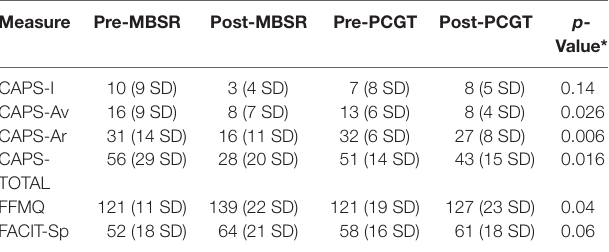
TaBle 2 | Effects of MBSR and PCGT on symptoms of post-traumatic stress disorder and measures of mindfulness and